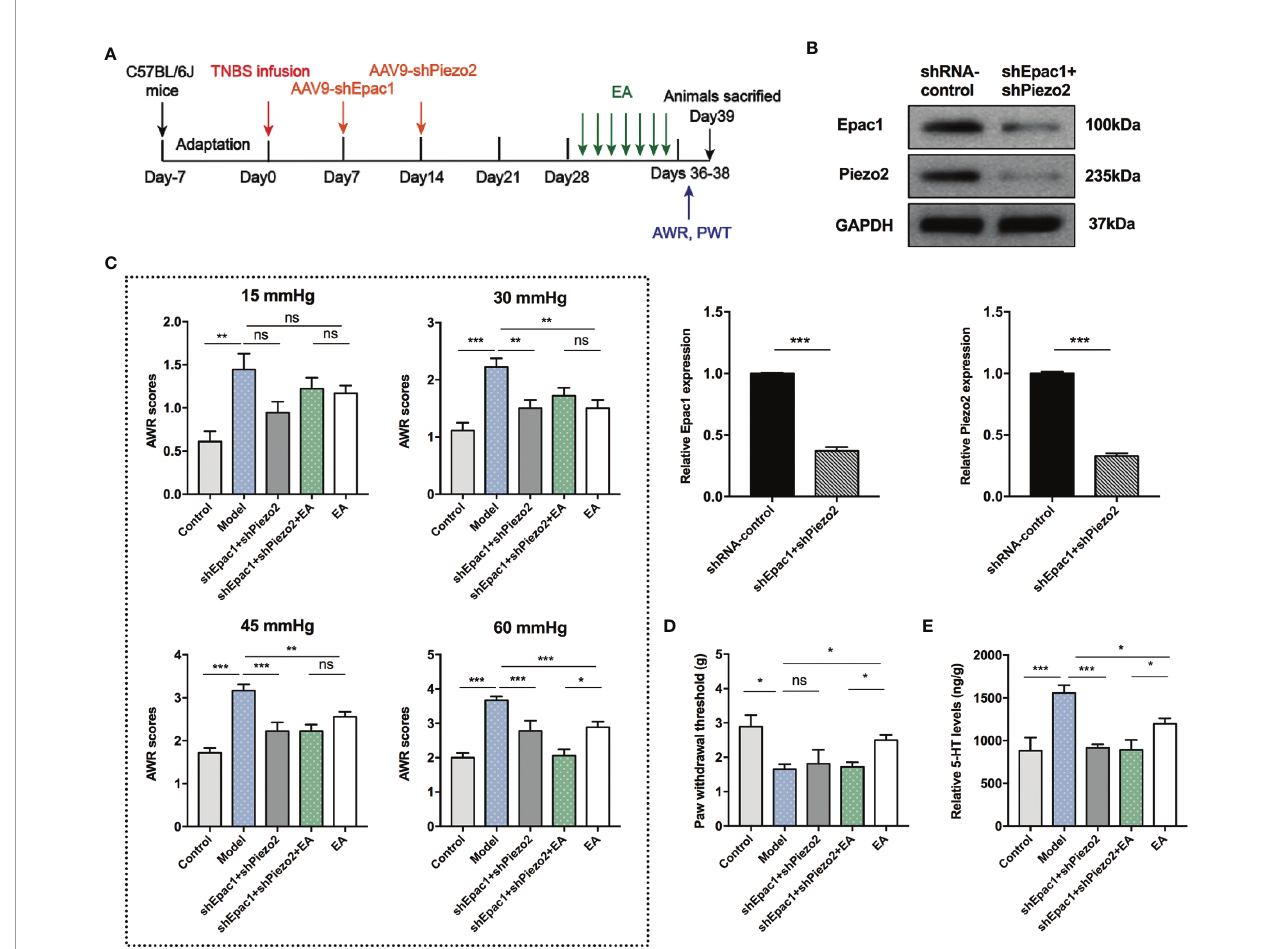
FIGURE 7 | Combined knockdown of colonic Epac1 and Piezo2 synergized with EA in relieving visceral hypersensitivity and eliminated the effect of EA on somatic hypersensitivity. (A) Schedule of the experimental procedures. (B) Representative Western blot analyses of Epac1 and Piezo2 staining and relative protein levels between the shRNA-control and shEpac1+shPiezo2 groups (n=3 per group). (C, D) Abdominal withdrawal re fl ex scores and hind paw withdrawal threshold evaluated in each group (n=6 per group). (E) ELISA analysis of 5-HT in colonic tissues (n=6 per group). Data are presented as mean ± SEM; (B) two-tailed t test; (C-E) One-way ANOVA with LSD multiple comparisons test; * P < 0.05, ** P < 0.01, *** P < 0.001, ns P